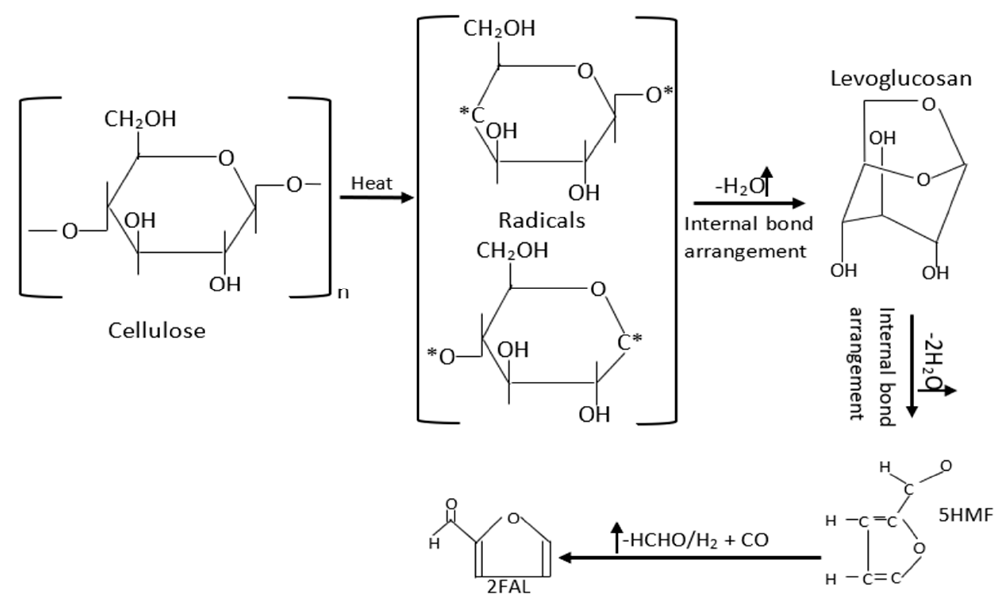
Figure 3. Pyrolysis mechanism in cellulose.